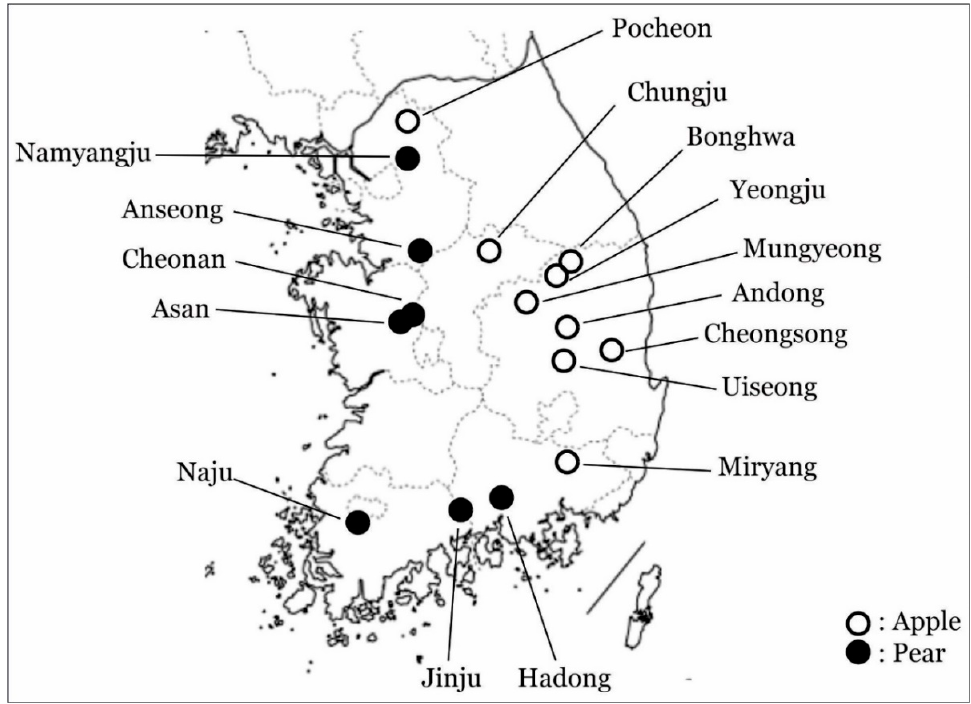
Figure 1. Geography of plant samples collected in this study for apple stem grooving virus